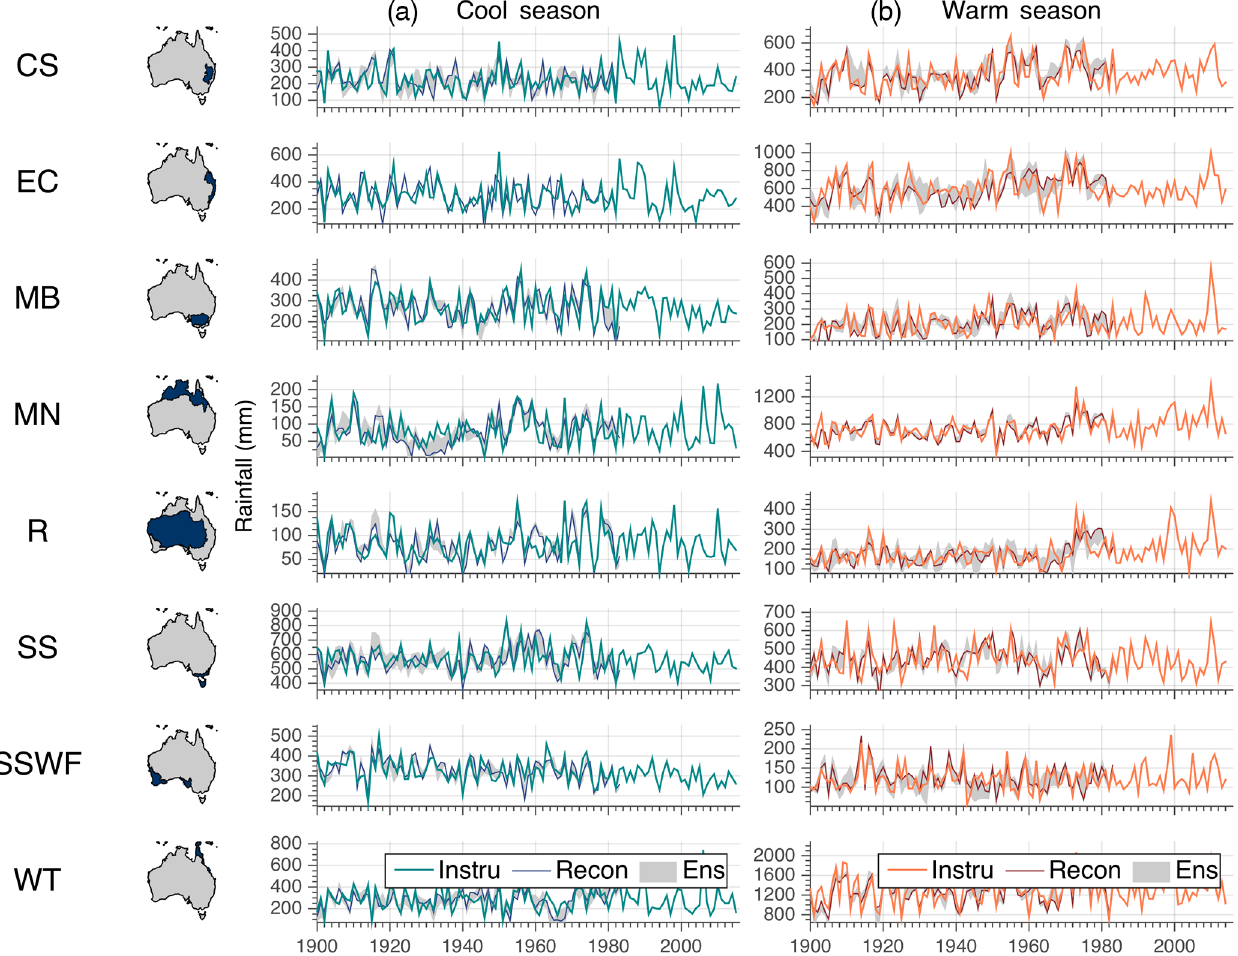
Figure 4. Australian regional rainfall reconstructions during the instrumental period (1900–2015). Reconstructed cool-season (a) and warm- season (b) rainfall is compared with the instrumental. Shaded in grey are uncertainty estimates based on the ensemble